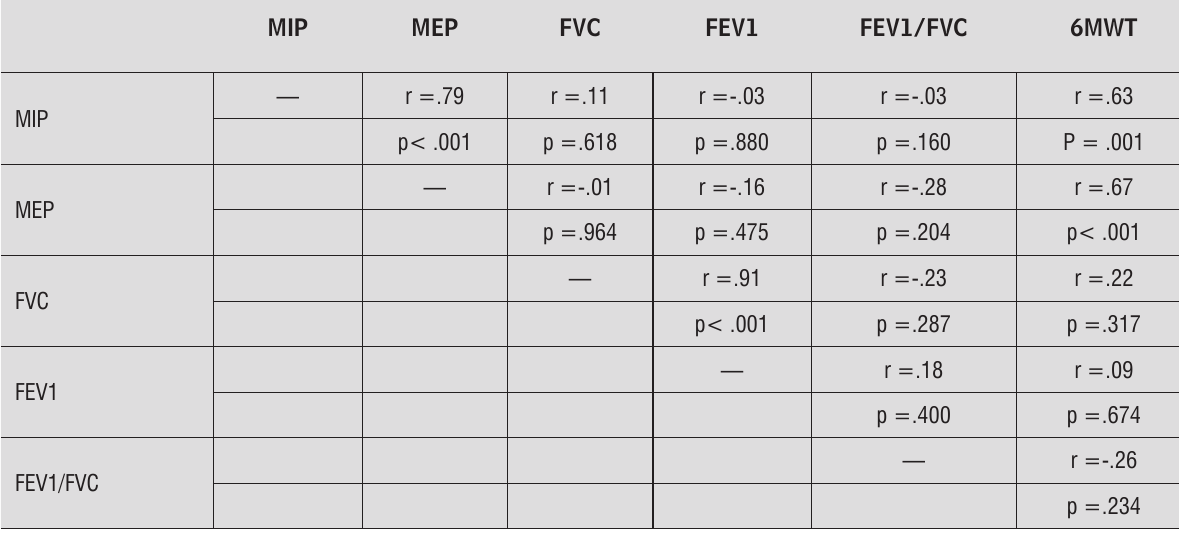
Table 3 - Correlations between spirometric variables, RMS and SMFC expressed as a percentage of that predicted for